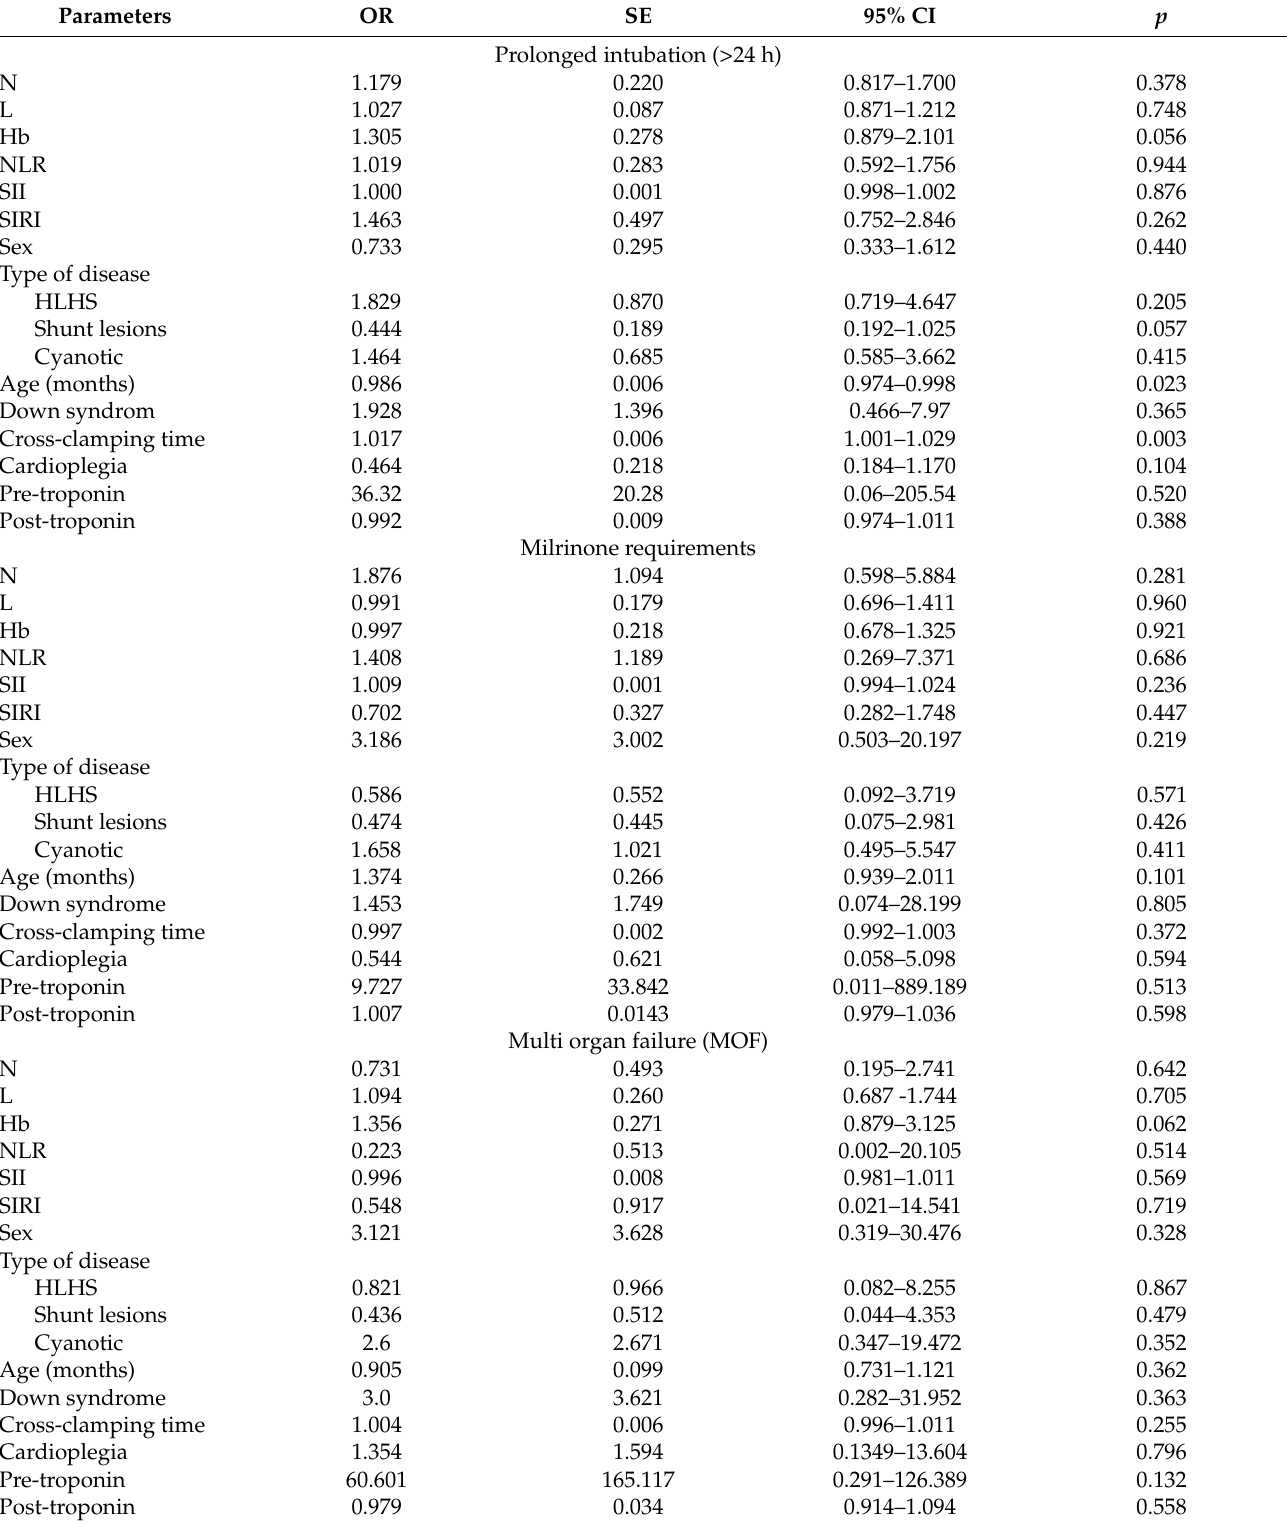
Table 3. Logistic regression analysis of factors related to postoperative